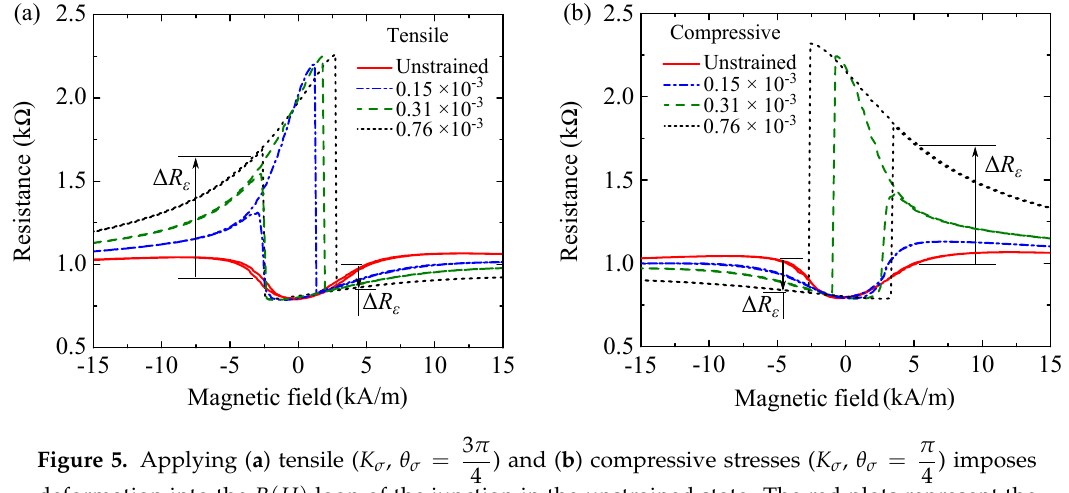
Figure 5. Applying ( a ) tensile ( K σ , θ σ = deformation into the R ( H ) loop of the junction in the unstrained state. The red plots represent the R ( H ) loop in the unstrained